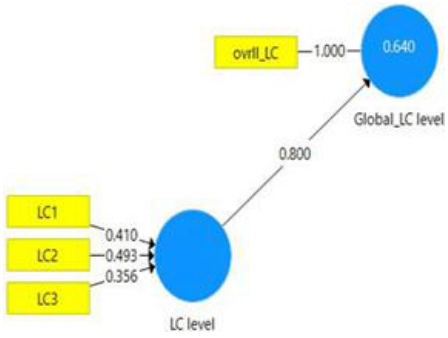
Figure 2. Redundancy analysis (LC level).